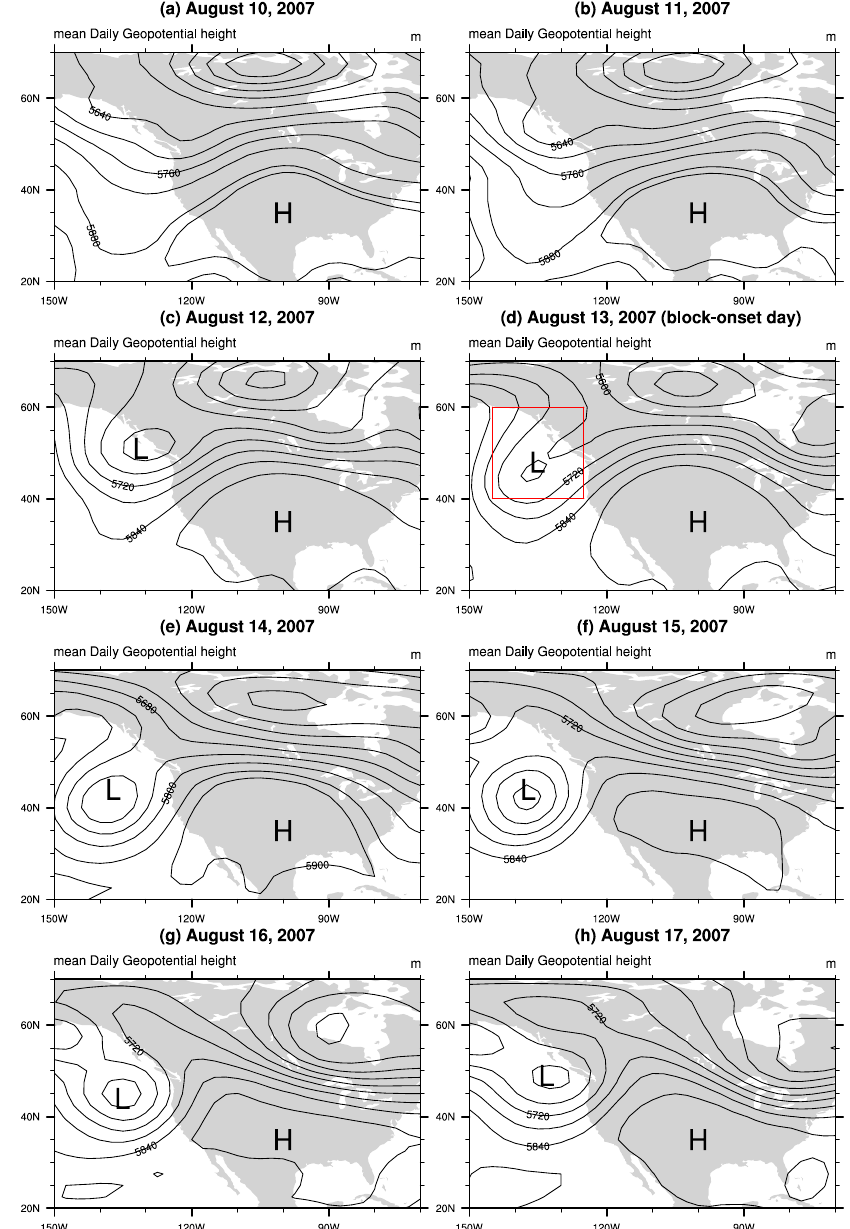
Figure 3. 500-mb geopotential heights during the evolution of the 2007 August blocking event from 10 August ( a ) to 17 August ( h ). The contour interval is 60 m. The block onset is on 13 August 2007. The block-onset region is outlined with a red rectangle on the block-onset day in ( d